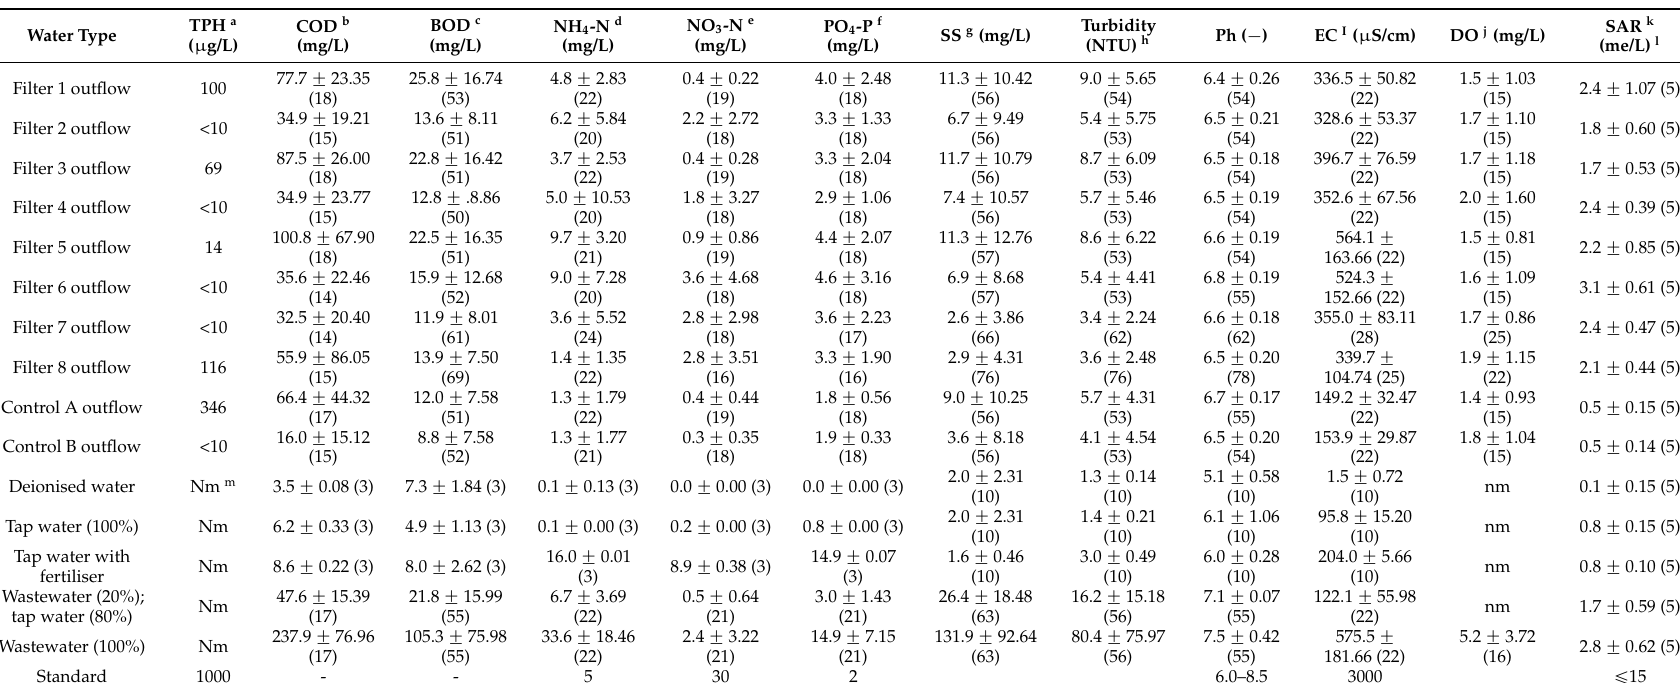
Table 4. Comparison of the water quality of the inflow waters received by the vegetable pots (mean ˘ standard deviation (number of samples)) between 11 October 2013 and 25 September